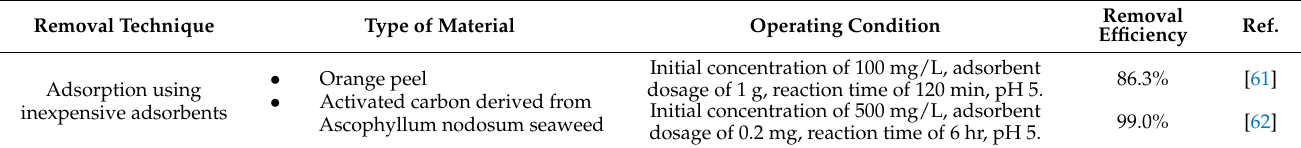
Table 5. Cu (II) removal efficiency using different treatment